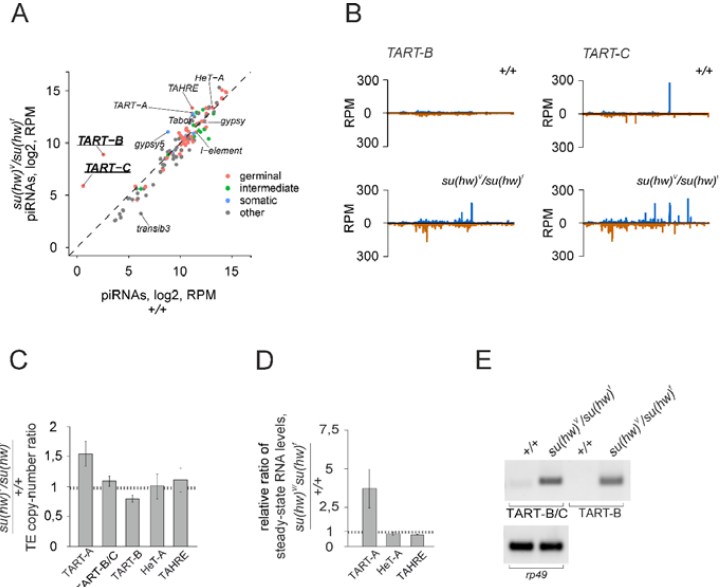
Figure 5. Su(Hw) depletion leads to the increased production of TART piRNAs. ( A ) Scatter plots of log2-transformed and RPM-normalized small RNAseq reads in the ovaries of wild type and su(Hw) mutant flies mapped to the canonical TE sequences. The colour of the dots indicates the type of TEs according to their capacity for maternal deposition in embryos according to [45]. ( B ) Small RNA mapping to canonical TART-B and TART-C telomeric retrotransposons. Reads mapped to the sense strand are shown in blue and antisense in brown. Analysis of ovarian small RNA libraries from KG10047 ;+/+ and KG10047 ; su(Hw) V /su(Hw) f strains (0–3 mismatches allowed) is shown ( A , B ). ( C ) qPCR on the genomic DNA was done to estimate relative copy number of telomeric retrotransposons in KG10047;su(Hw) V /su(Hw) f compared to KG10047 ;+/+ strain. Normalization to the single-copy rp49 gene was done. ( D ) RT-qPCR analysis of transcript levels of TART-A, HeT-A and TAHRE telomeric elements normalized to rp49 in the ovaries. Shown are fold changes of steady-state RNA levels in KG10047; su(Hw) V /su(Hw) f compared to KG10047 ;+/+ strain. ( E ) Agarose gel electrophoresis of RT-PCR products demonstrates increased levels of TART-B and TART-C transcripts in Su(Hw) mutants. Rp49 is used as a loading